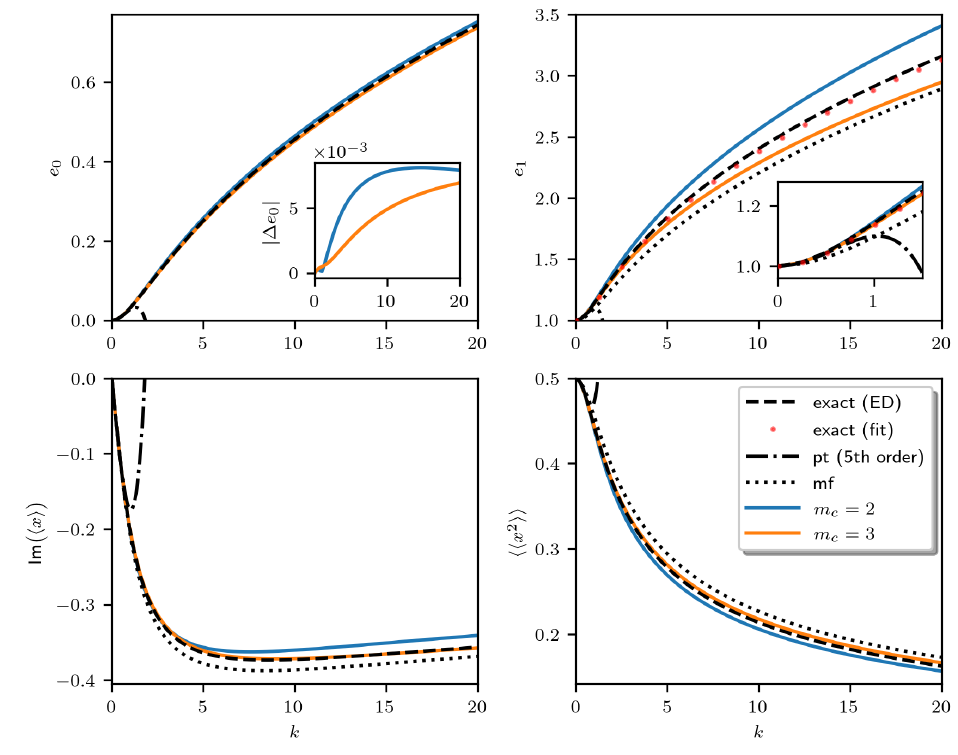
Figure 3: Results for quantum theory. We show the ground state-energy = E − E | = E − E | e , first excitation energy e , vacuum expectation value k = 0 k = 0 0 0 0 1 1 1 〈 x 〉 and fluctuations 〈〈 x 2 〉〉 . Exact results obtained from ED are compared with per- turbation theory (pt, dash-dotted), mean-field theory (mf, dotted) and FRG (full, = 2,3. Exact fit denotes the calculation of e color-coded) truncated at m c the exact propagator as outlined in section 3. The inset in the top-left shows the absolute-difference between the exact e and 0